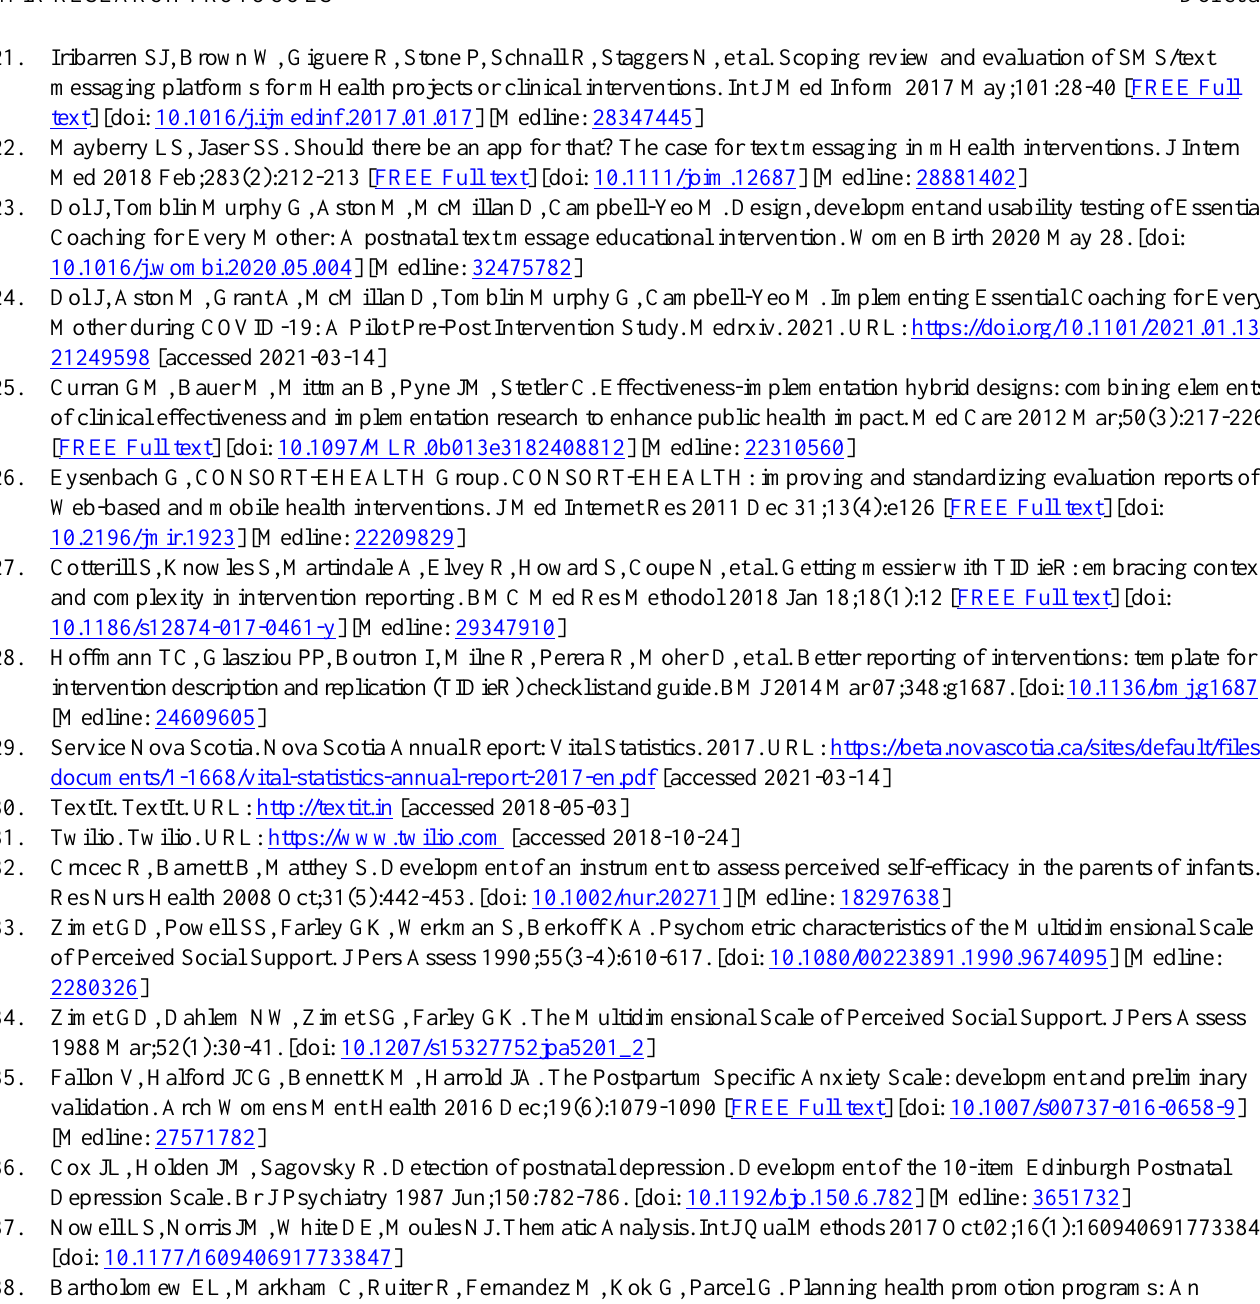
Abbreviations ANCOVA: analysis of covariance CONSORT-EHEALTH: Consolidated Standards of Reporting Trials of Electronic and Mobile HEalth Applications and onLine TeleHealth EPDS: Edinburgh Postnatal Depression Scale KPCS: Karitane Parenting Confidence Scale mHealth: mobile health MSPSS: Multidimensional Scale of Perceived Social Support PSAS: Postpartum Specific Anxiety Scale REDCap: Research Electronic Data Capture TIDieR: Template for Intervention Description and